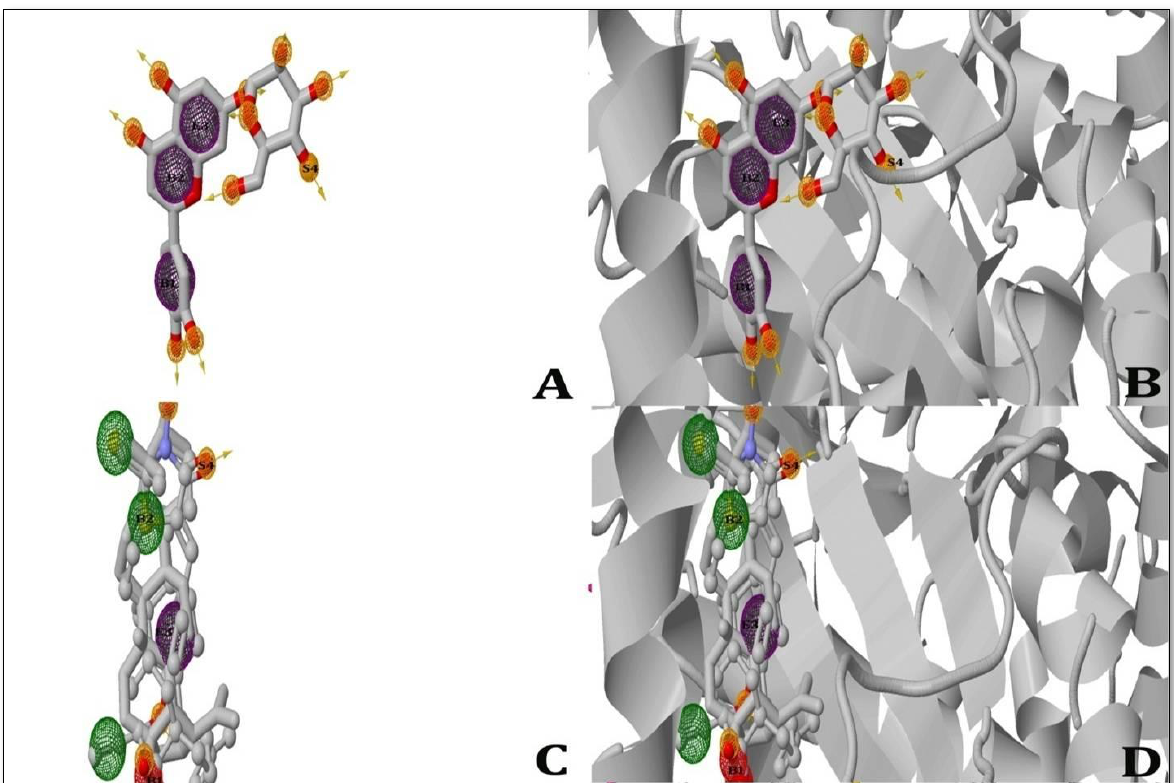
Figure 3. 3D depiction of the pharmacophore study used to generate the ligands showing inhibition of the MAP Dephospho-Coenzyme A kinase (DPCK) protein; ( A ) Solasodine ligand (left); ( B ) Solasodine pharmacophore (right); ( C ) Ursolic acid ligand (left), ( D ) Ursolic acid pharmacophore (right). The interactions between the ligand and the receptor in the study are shown as ball-and-stick models, where green represents pi-cations; blue represents Alkyl bonds; and yellow represents hydrogen interactions. The poor interaction between the ligands and pharmacophore was analyzed by ZINC Pharmer 2022 version.